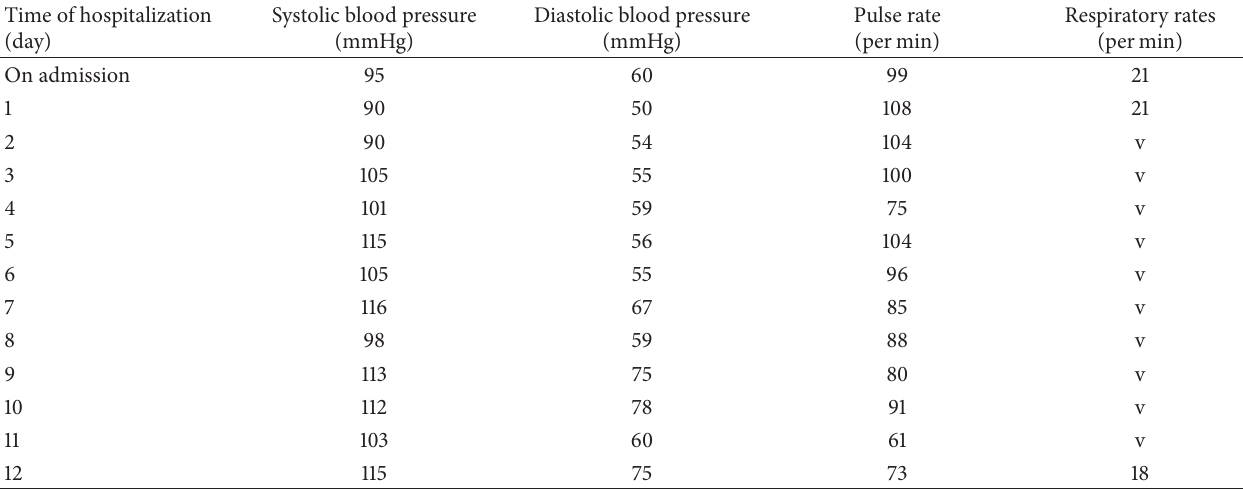
Table 1: Vital signs (systolic and diastolic blood pressure, respiratory rates, and pulse rate) of patient during hospitalization (on admission and at 8.00 a.m. each day).